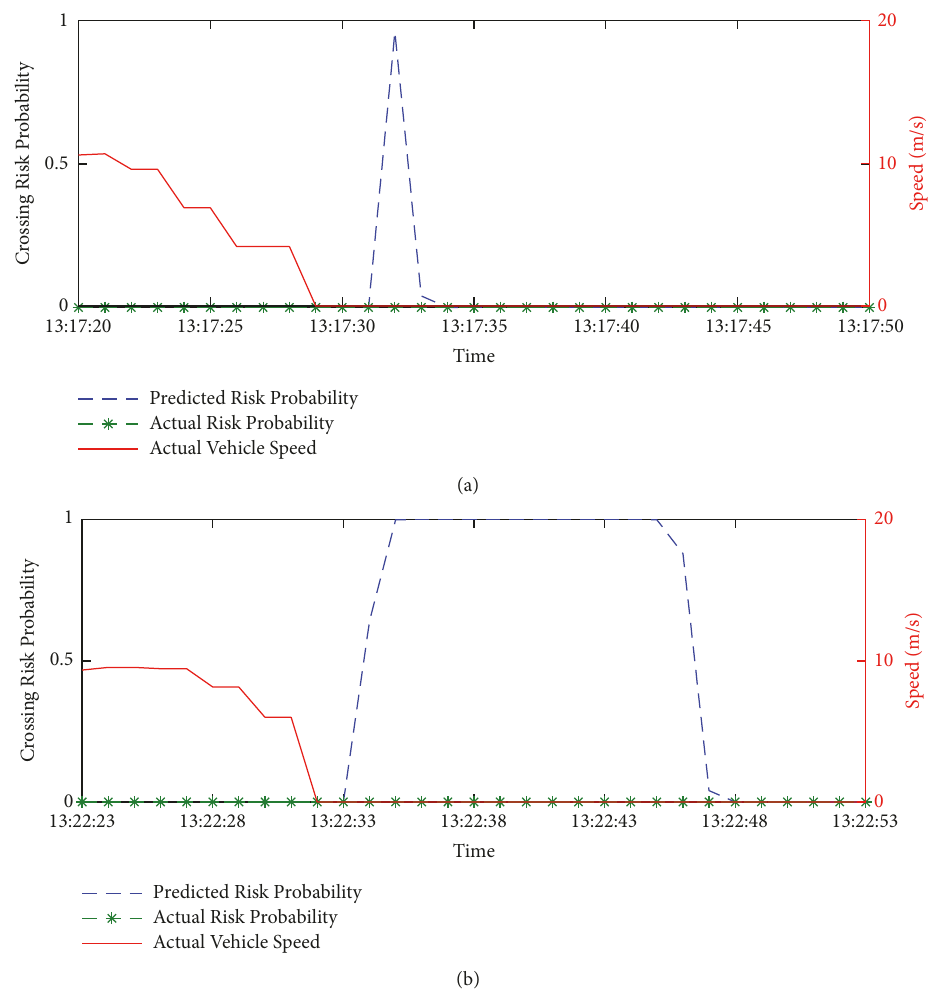
Figure 9: Field test results. (a) Test 1. (b) Test